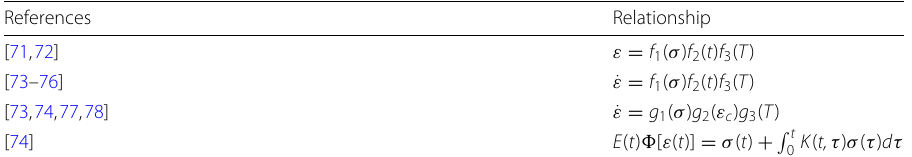
Table 3 Commutator table of the Lie algebra of Eq. (3.32) v 1 1 v 2 1 v 1 1 0 β v 1 1 + v 2 1 v 2 1